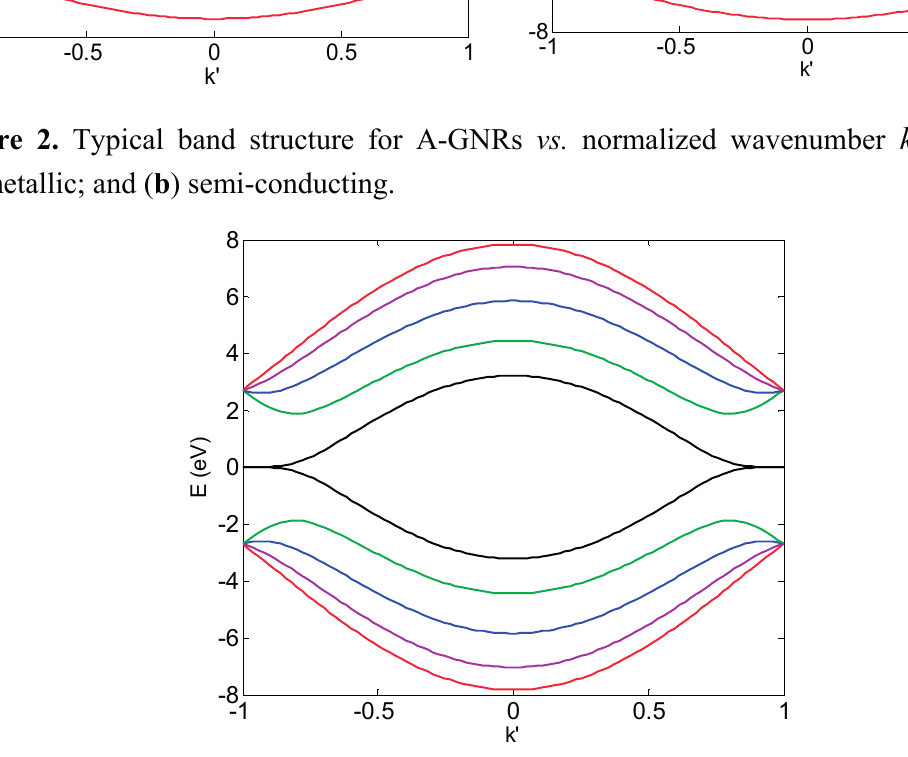
Figure 3. Typical band structure for Z-GNRs vs. normalized wavenumber ' / π k kT =